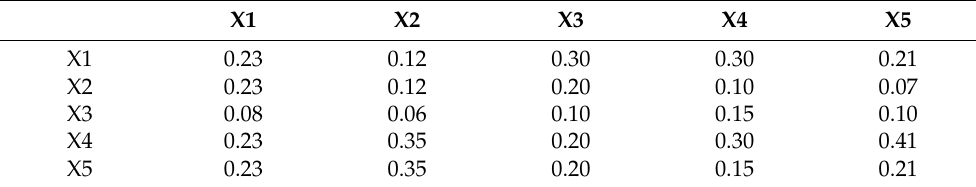
Table 6. The normalized pairwise comparison matrix.